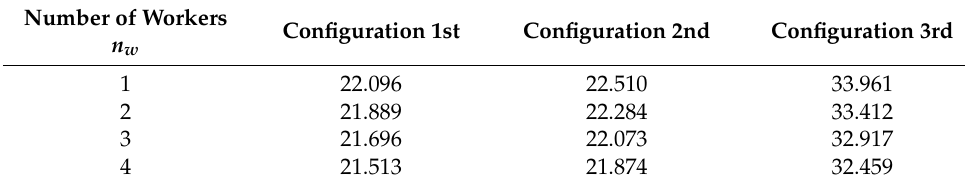
Table 9. The critical value of the wind speed V CRT